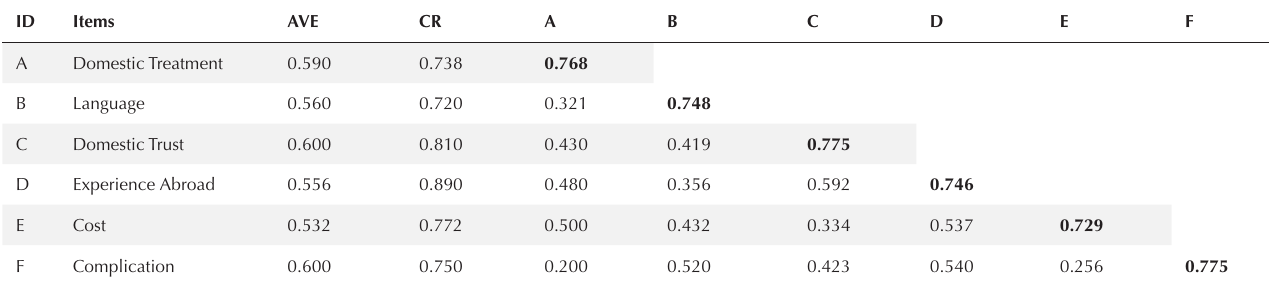
Table 2. CR, the Square Root of the AVE (in bold), and Correlations Between Constructs (Off-Diagonal) ID Items